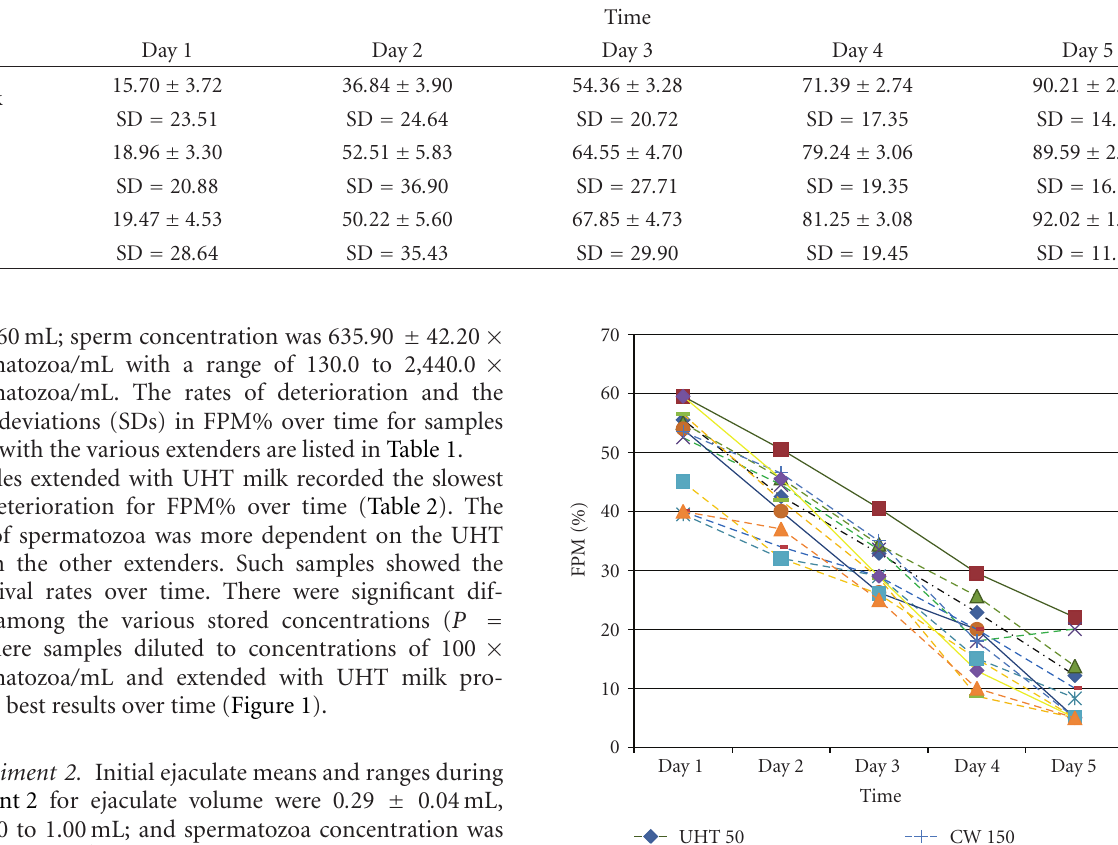
Table 2: lists the mean rates of deterioration and SD for FPM% where the various spermatozoa concentrations of the various extenders over time are pooled. Extenders